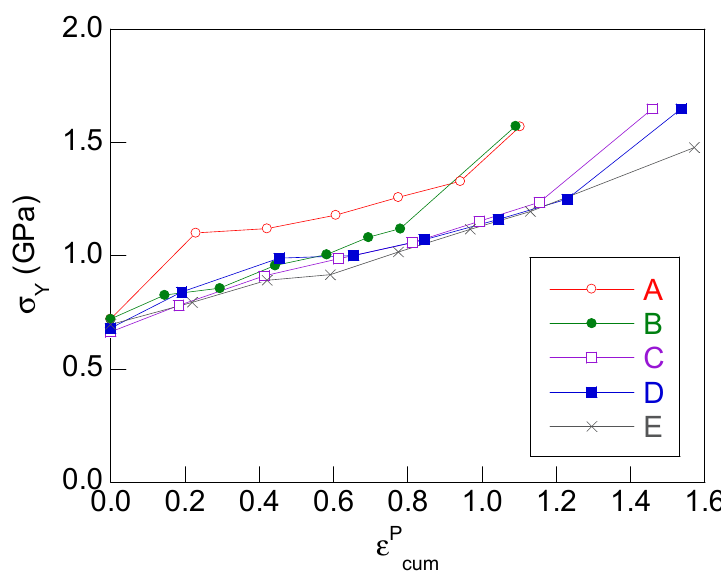
Figure 3. Evolution with cold drawing of the yield strength σ Y .